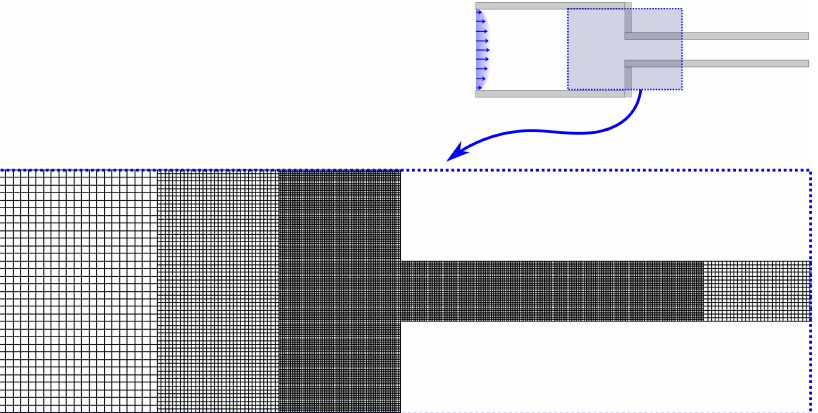
Figure 9. Graphical representation of the mesh M 1 used in the contraction